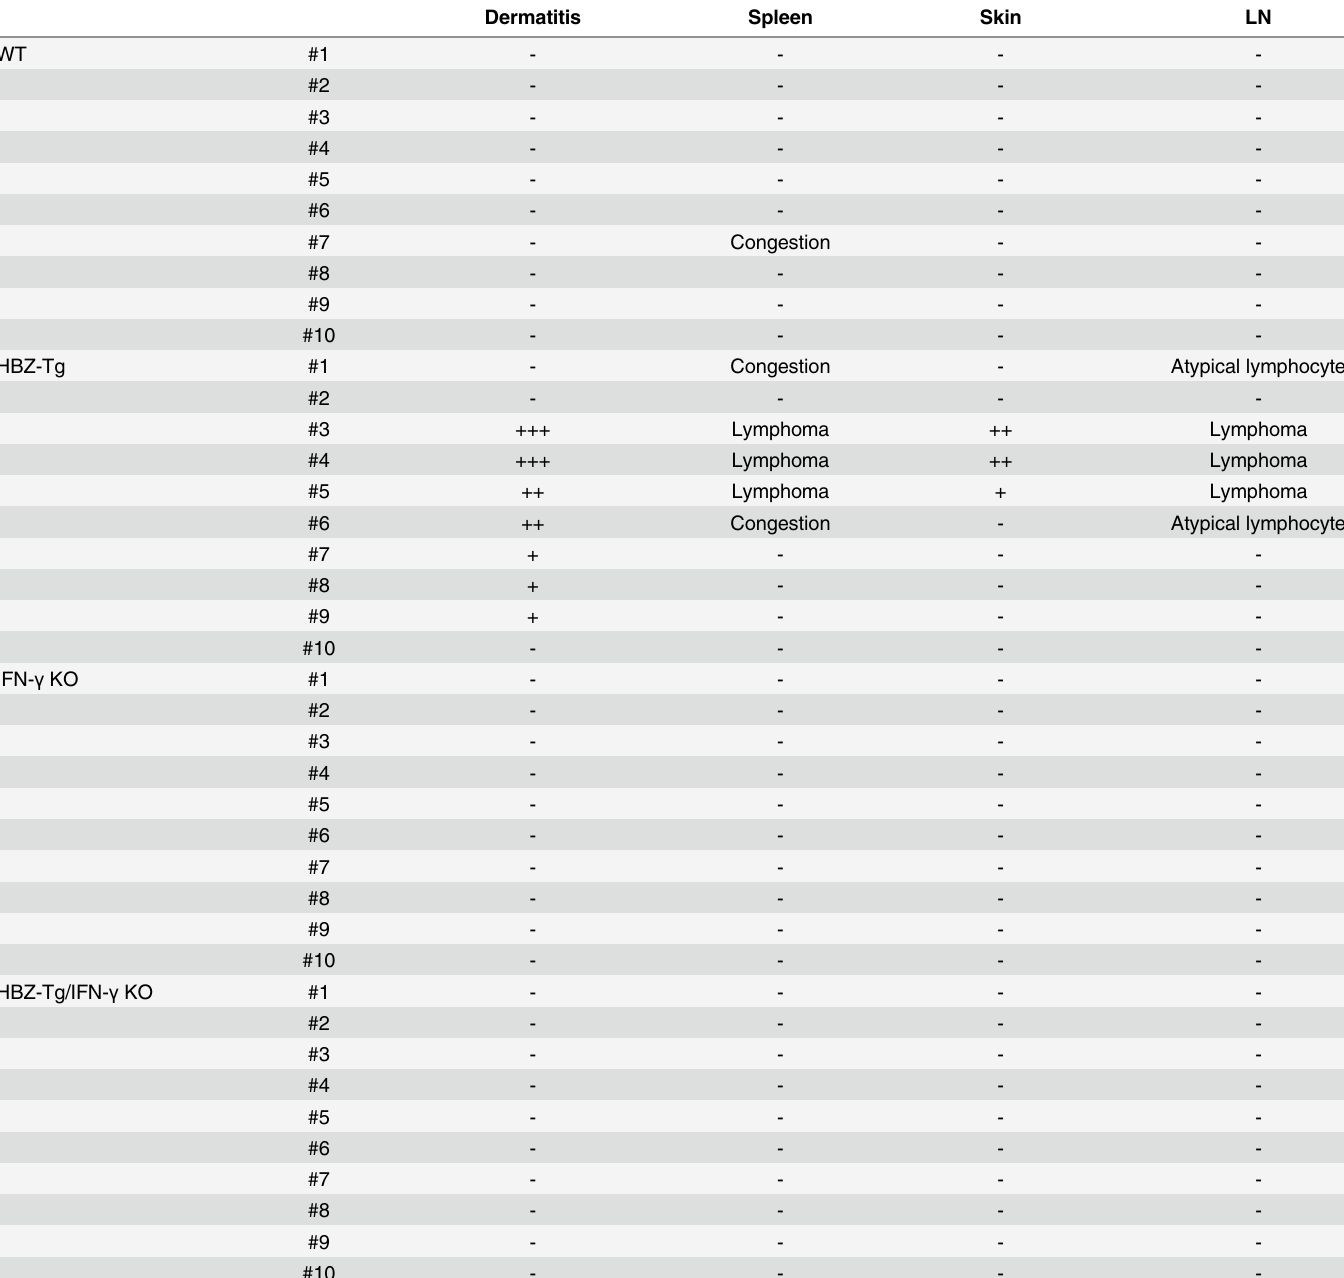
Table 1. Histological findings in WT, HBZ-Tg, IFN- γ KO, and HBZ-Tg/IFN- γ KO mice at 24 weeks of